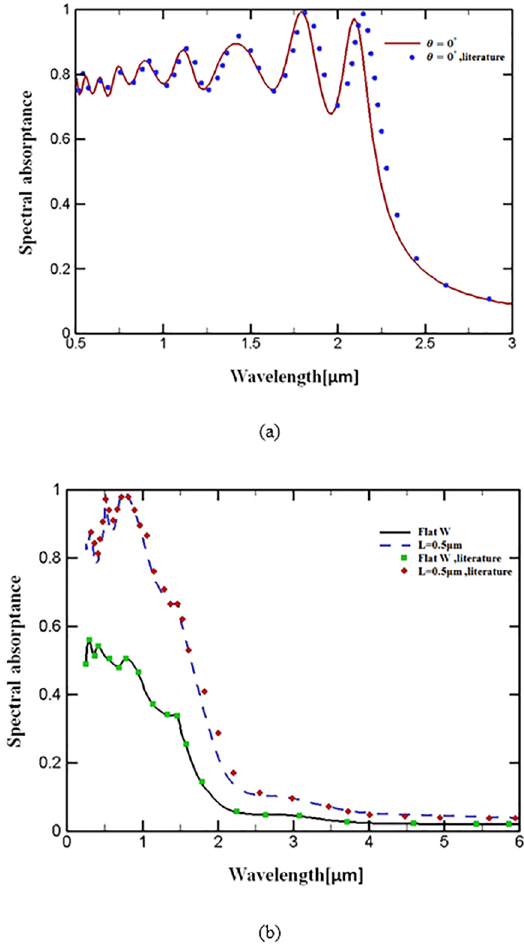
Figure 2. Absorptance spectra from literature (10) and current simulation for (a) nano circular pattern (b) flat tungsten and nano square